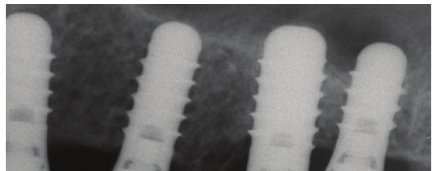
Figure 4: Postoperative radiograph of the left maxillary quadrant four months after the placement of three implants with better initial stability medially and distally to the first implant showing the new sinus floor with all the implants appropriately positioned and inclined.